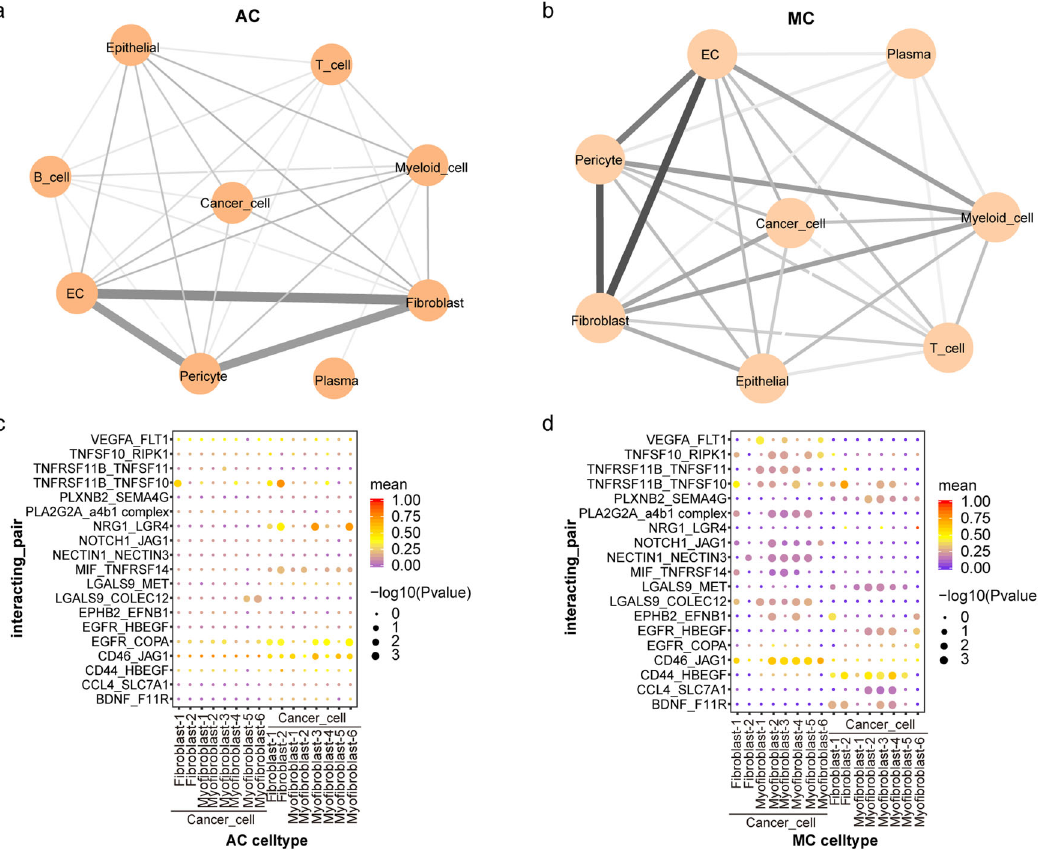
Fig. 10 Cell ‒ cell communication in MC and AC. The cellular interaction network among different cell types in AC (a) and MC (b) . The line width and colour are proportional to the number of interactions between cell types. Selected ligand ‒ receptor interaction pairs in AC (c) and MC (d) . Colour key from blue to red represents mean expression of two genes in the interacting pair from low to